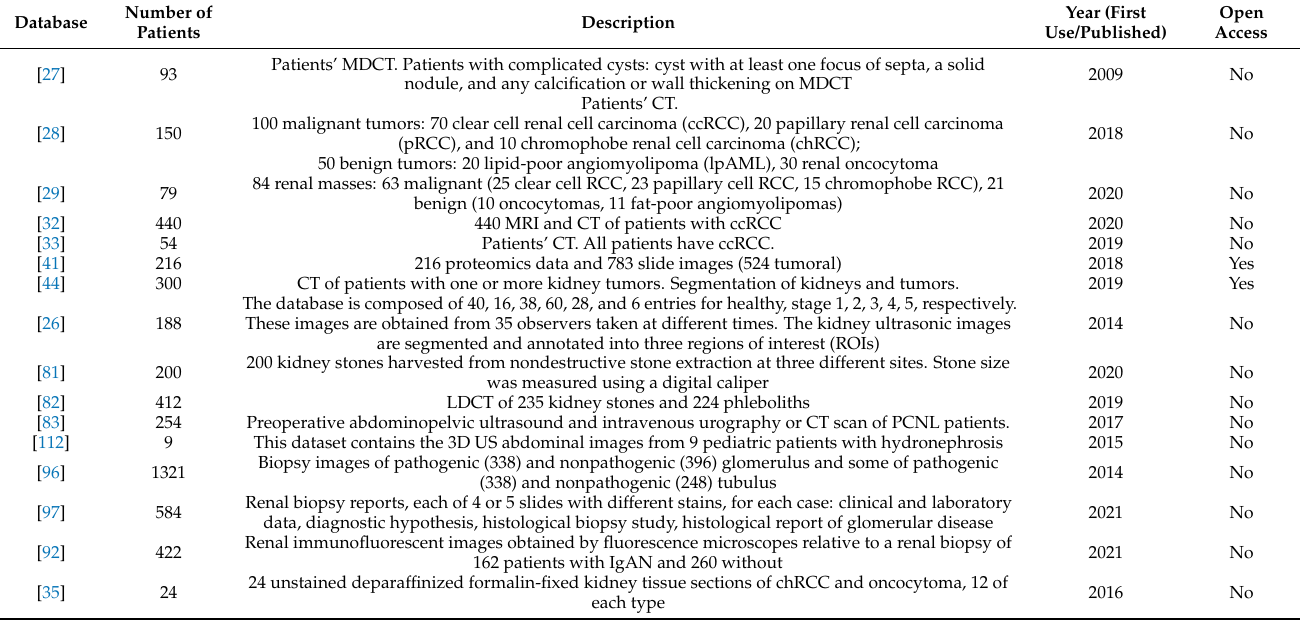
Table 8. Diagnostic image